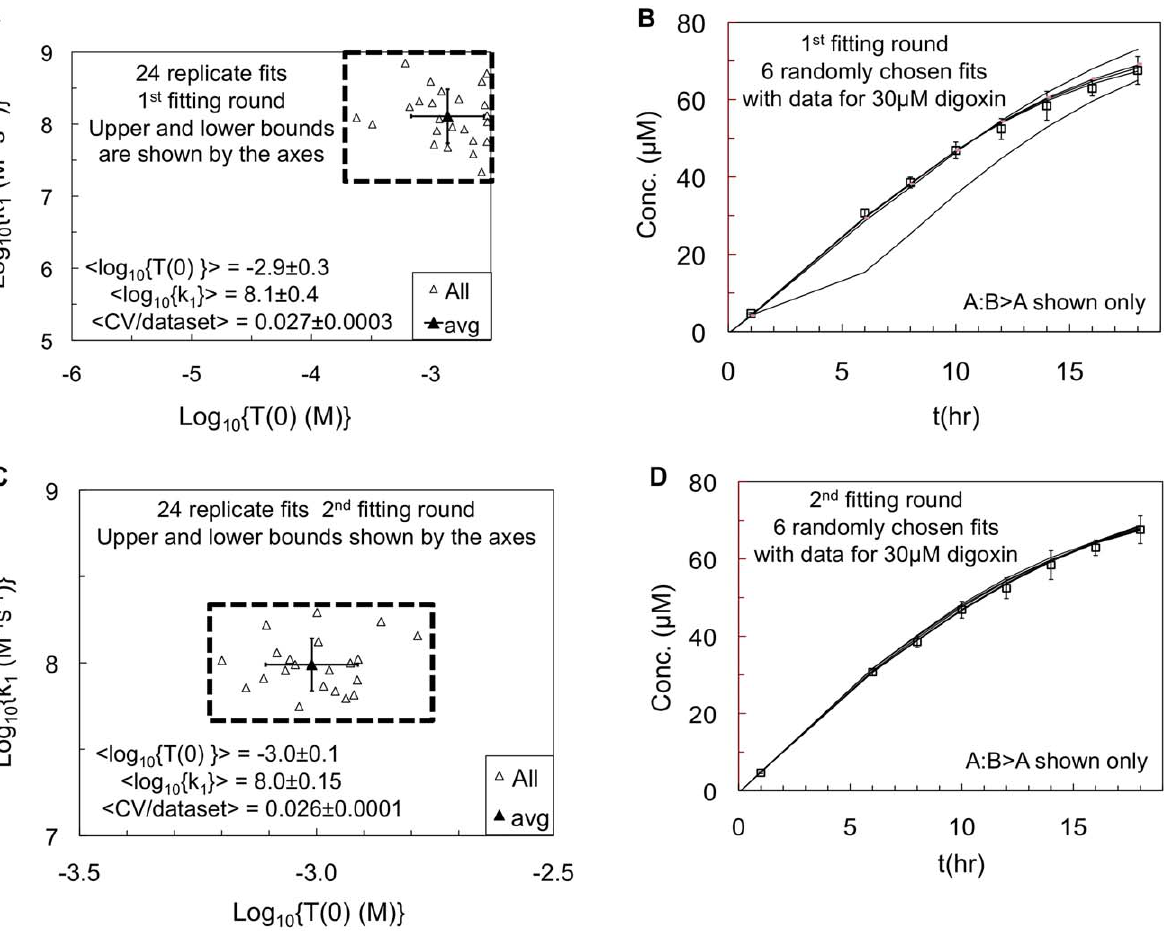
Figure 3. Simultaneous fits of P-gp efflux active surface density, T(0), and association rate constant, k 1 . 24 independent replicate fits of all 72 experimental data from Tran et al. [23] and Acharya et al. [29], [30]. All 13 kinetic parameters were simultaneously fitted to all relevant datasets. For all figures, the x- and y-axes show the user-fixed lower and upper bounds used in each fitting round. Fig. 3A shows the 1 st round of fitting for the drug independent values of the surface density of efflux active P-gp in the apical membrane, T(0) , and the association rate constant k 1 . The open triangles show the 24 individual fitted values. The solid triangle shows the log-average and the error bars are the standard deviation for the 24 individual fits, which are also written onto the figure. The average coefficient of variation over all data sets and the 24 replicate fits, , CV/dataset . , is also shown with its standard deviation. Fig. 3B shows the A:B . A trajectories of 6 randomly chosen fits from the data for 30 mM digoxin transport, as an example. Four of the trajectories are on-target with the data, one is close and one is off-target. Fig. 3C shows the results for the 2 st round of 24 independent replicate fits, which was started as a fresh run with upper and lower bounds shown by the dashed box in Fig. 3A, together with appropriately reduced upper and lower bounds for the drug dependent kinetic parameters. The consensus average values, standard deviations and the ranges are given in Table 1. Fig. 3D shows the A:B . A trajectories of 6 randomly chosen fits from the 2 nd round for 30 mM digoxin transport, like Fig. 3B. All six trajectories are on-target with the data and tighter than found in Fig. 3B for the 1 st round, hence the reduced range of fitted